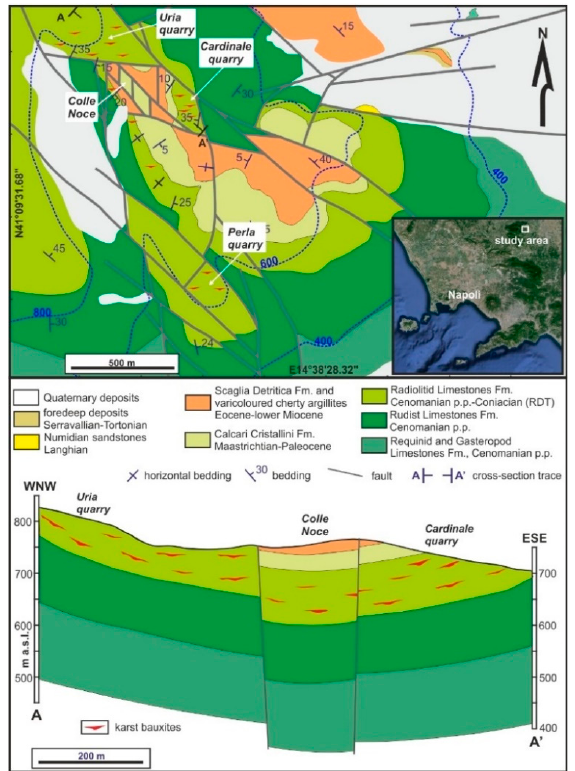
Figure 1. Geological map and cross section of the study area (modified after [28]).